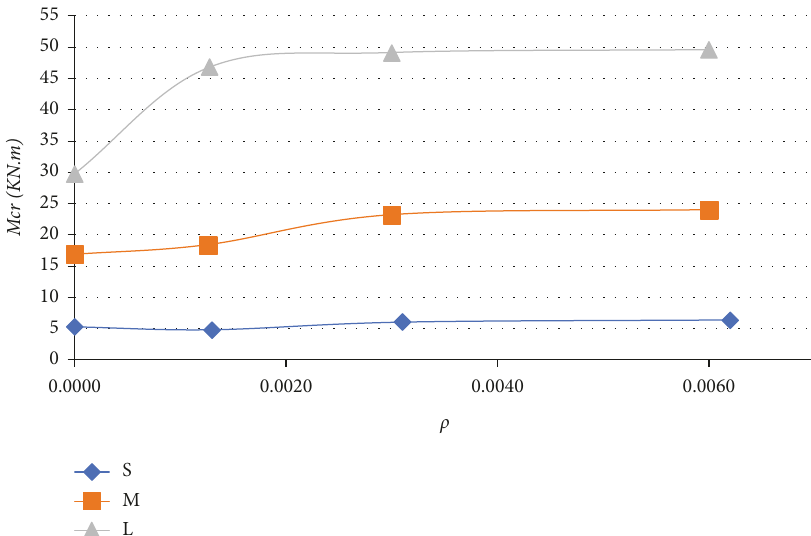
Figure 12: Effect of reinforcement ratio on the cracking moment.